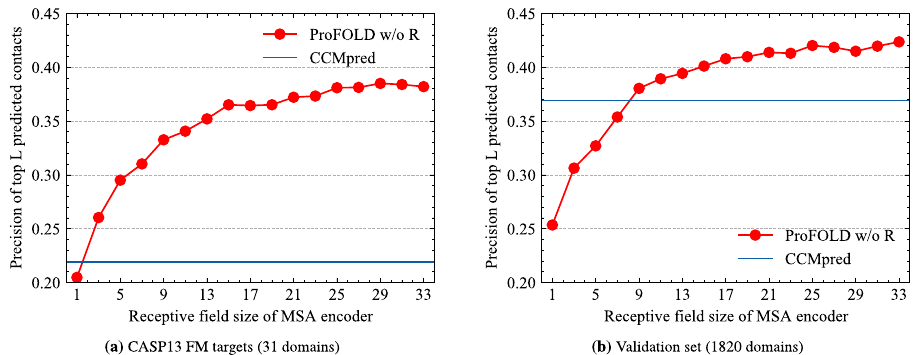
Fig. 4 Precision of the predicted inter-residue contacts by the variant ProFOLD w/o R . a For the 31 CASP13 FM targets, the precision increases with the receptive fi eld size and fi nally reaches 0.382. b On the validation set with 1820 proteins, the precision also increases with the receptive fi eld size and fi nally reaches 0.424. Even using the "encoder and aggregator'' framework alone, the variant ProFOLD w/o R still outperformed CCMpred on the two datasets (0.219 and